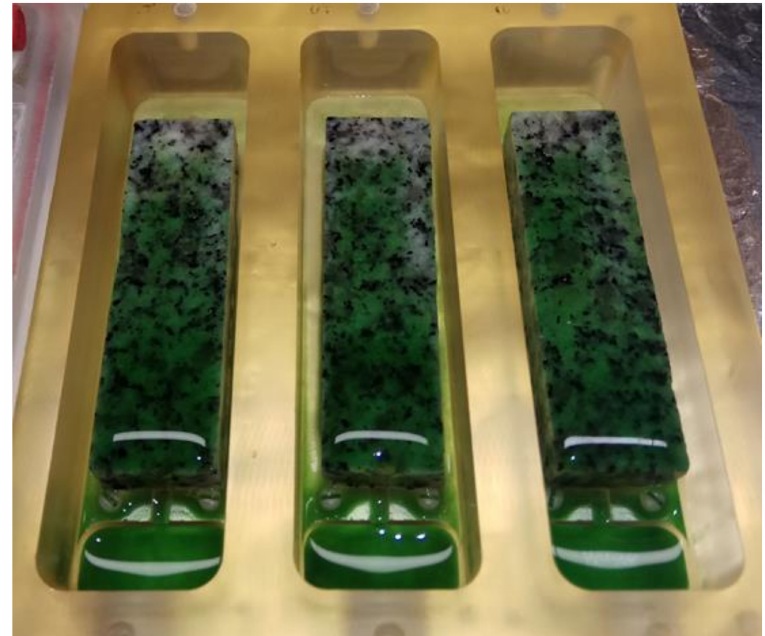
Figure 1. Biofilms formed on granite samples after incubation for 21 days in a drip flow reactor with carbon-enriched medium.